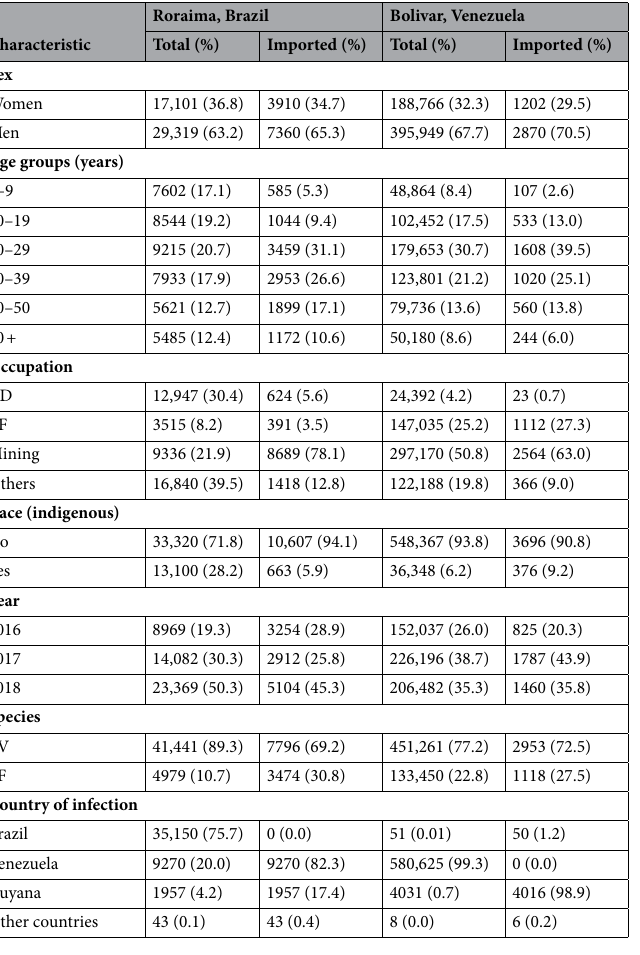
Table 1. Socio-demographic characteristics of total and imported malaria cases in Roraima, Brazil and Bolivar, Venezuela: 2016–2018. PV Plasmodium vivax , PF Plasmodium falciparum, AD agriculture and domestic, TF tourism, fishing and timber, others other